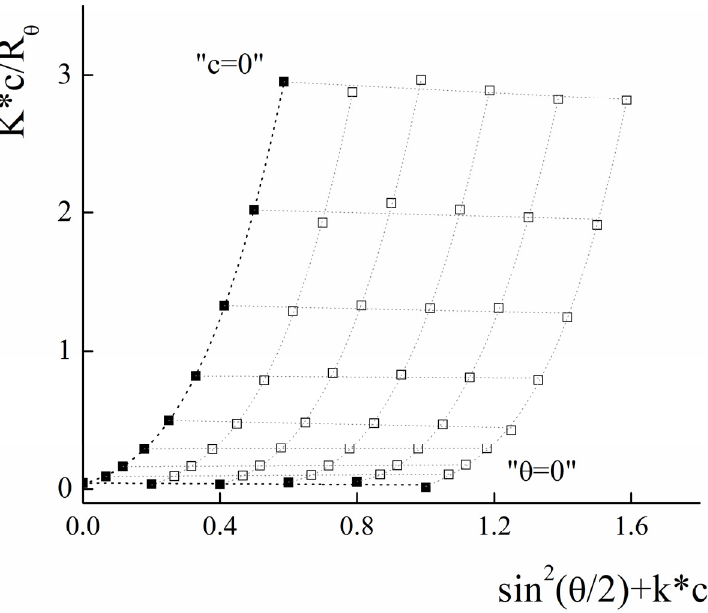
Figure 12. Zimm plot for PLAMs–PTX (blank squares correspond to experimental data, solid squares correspond to extrapolation data). Tris buffer with pH 7, c = 0.01 M, 25 °C.